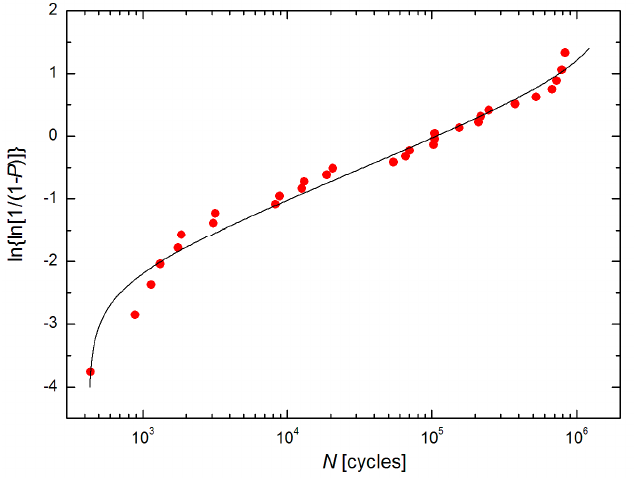
Figure 10. Weibull plot of fatigue life (the number of cycles to fracture) for the S10 concrete specimens loaded with the maximum flexural stress of 3.828 MPa at the frequency of 2 Hz [14].